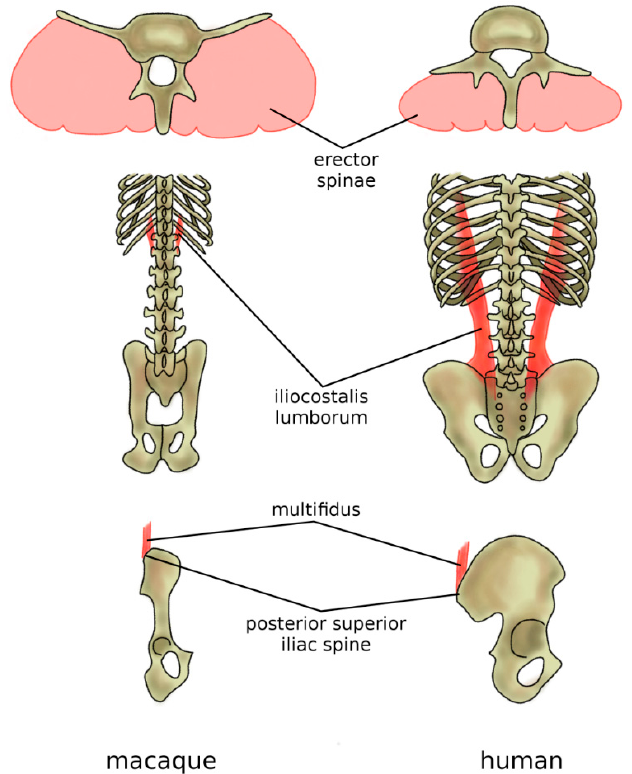
Figure 10. Adaptations of the back musculature of humans (in comparison with macaques) to allow for bipedal stance and gait. In humans and all other hominoids, the erector spina are dorsally located and functions, therefore, as an extensor (top), whereas, in the macaque, it is more ventrally located and has only a minor extensor function. The caudal insertion of the iliocostalis lumborum moved from the lumbar spine to the iliac crest (middle), thus enhancing its lateral flexor function. Specifically, in humans, the posterior superior iliac spine which acts as the iliac insertion of the multifidus is markedly more posterior, thus providing an additional lever arm and room for muscle mass (bottom).